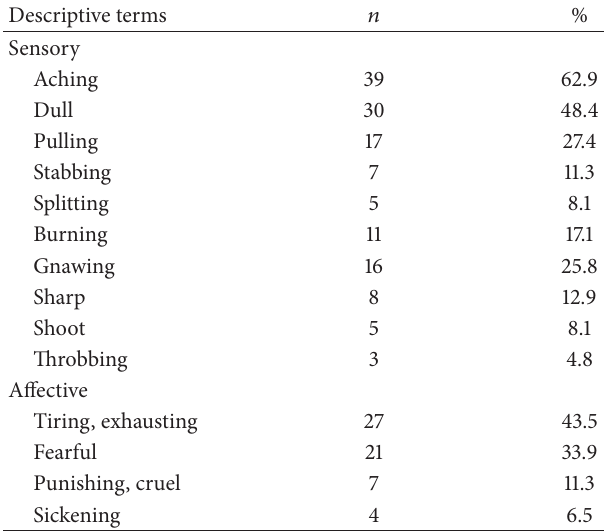
Table 2: Percentage of patients experiencing pain who selected a term to describe it.